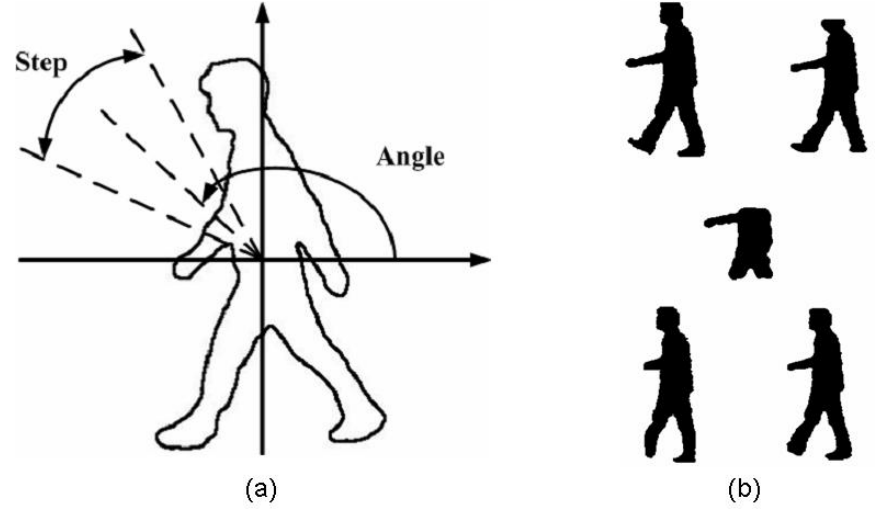
FIGURE 7. (a) RIT estimation, (b) KR moments